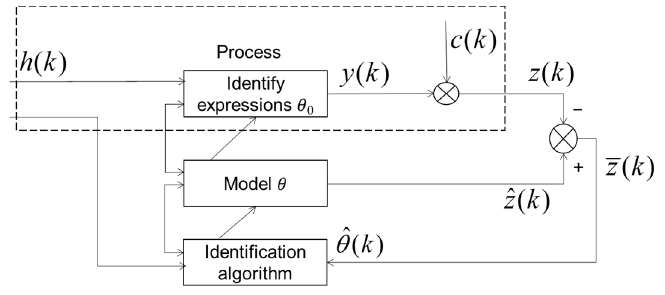
Figure 13. System identification structure.